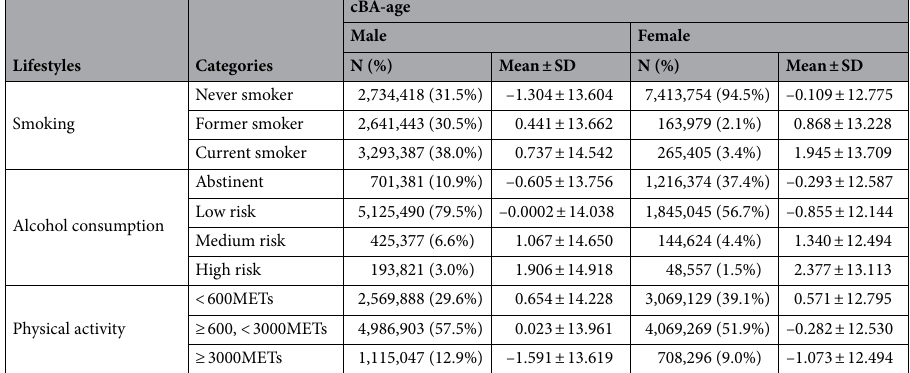
Table 6. The relationship between lifestyles and MS BA. All parameters are P <